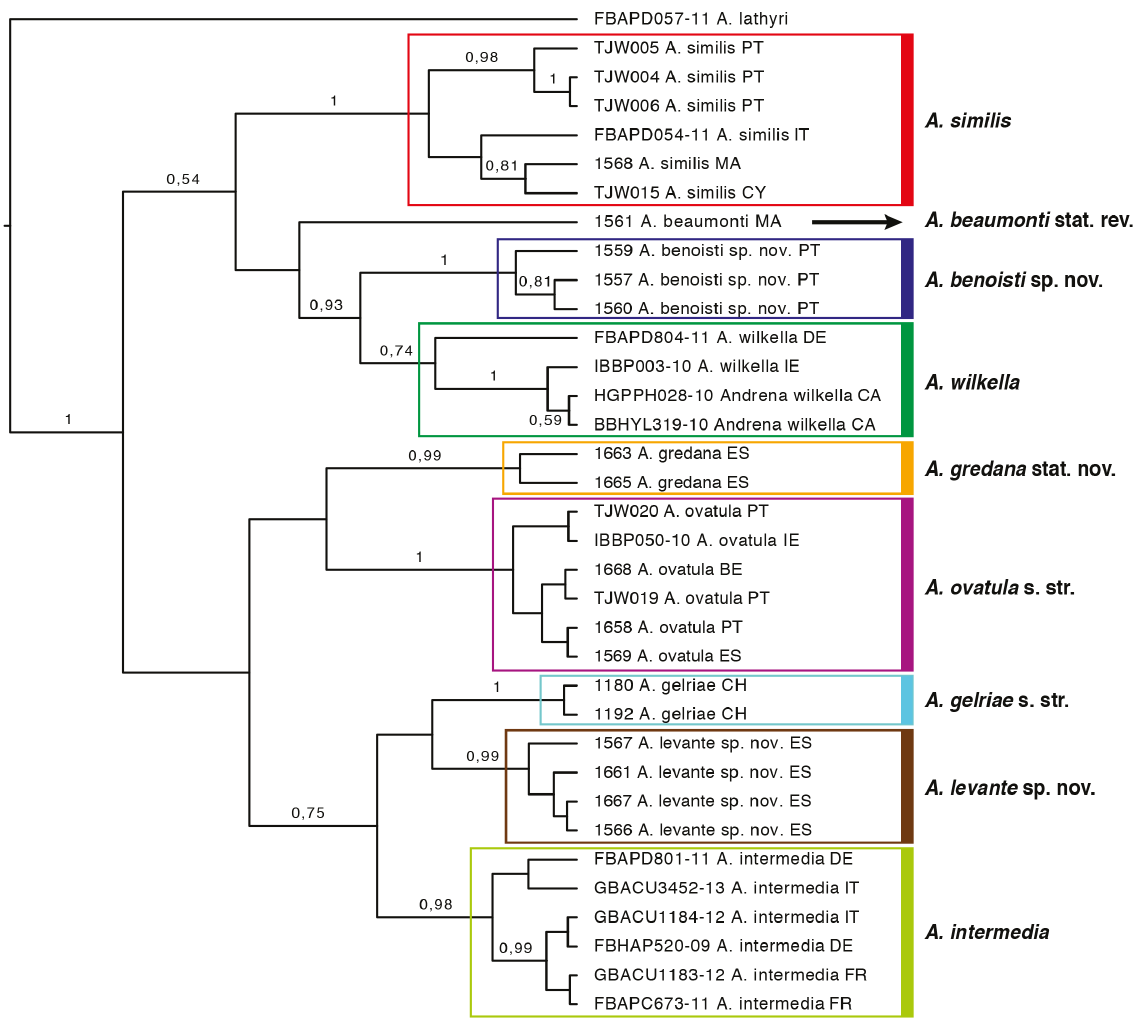
Fig. 1. Molecular phylogeny of the subgenus Taeniandrena Hedicke, 1933 with a focus on West Mediterranean species. Maximum clade credibility tree found in Bayesian analyses of sequence data of the mitochondrial gene COI; numbers above branches indicate posterior probabilities; values below 0.5 are